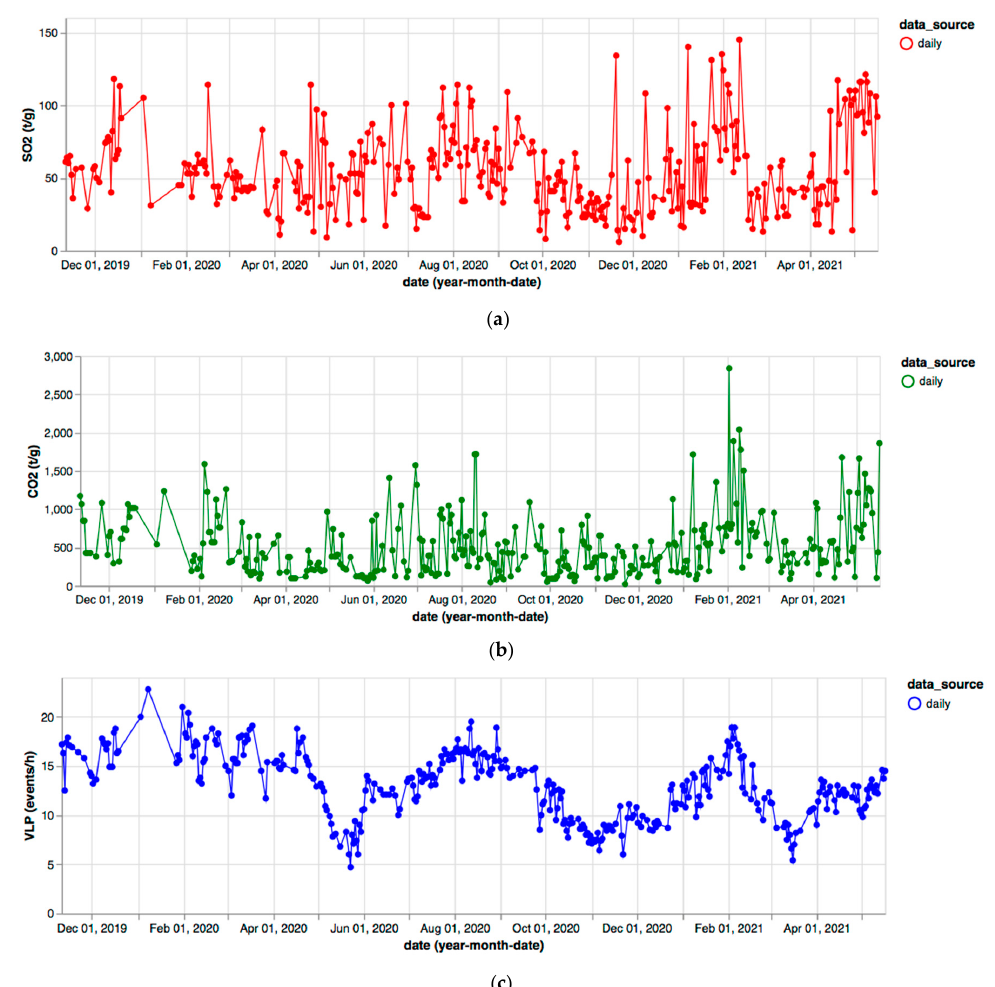
Figure 7. ( a ) SO 2 flux; ( b ) CO 2 flux; ( c ) VLP time series extracted from LGS bulletins in 2019–2021. The observable quantities, i.e., SO 2 integrated mass flux and CO 2 mass flux, repre- sented in the graph show a coherent behavior over time (Figure 8).